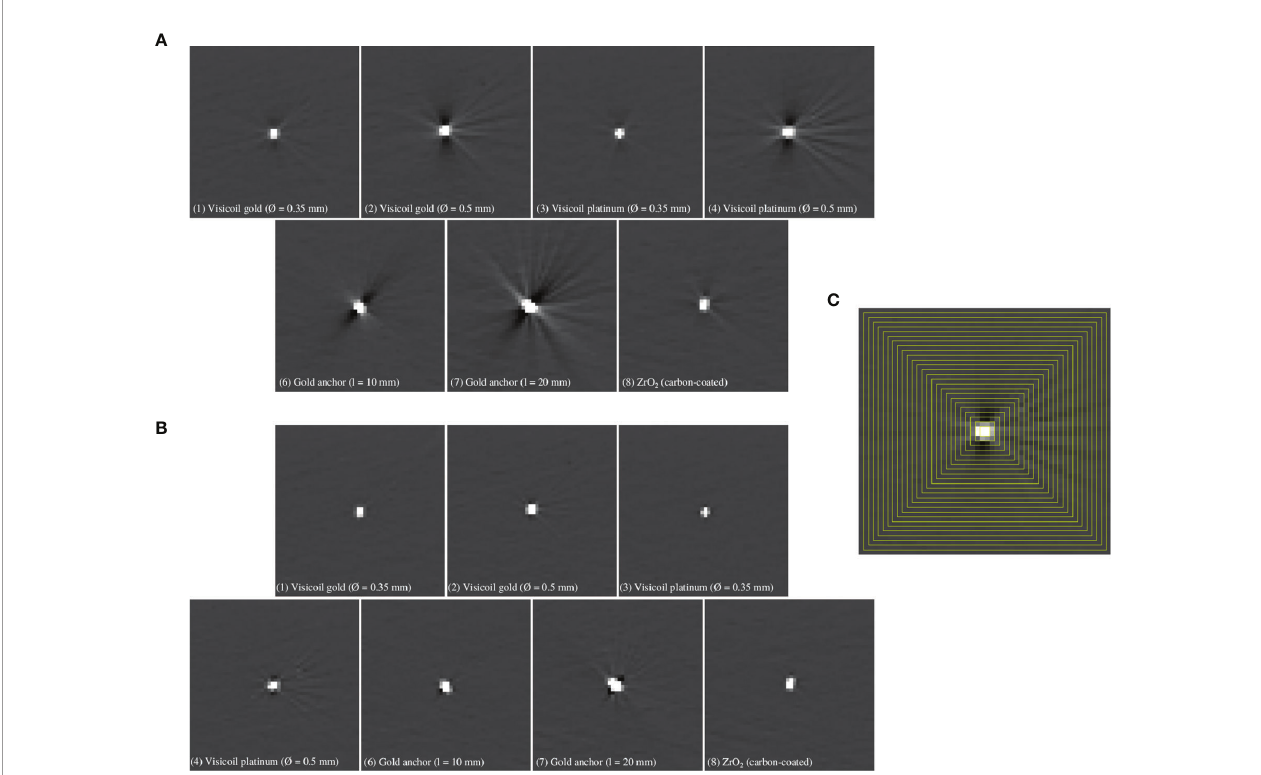
FIGURE 3 | Reconstructed images for conventional treatment planning CT (A) and with iMAR correction (B) of 0.5mm slice thickness for 7 different fi ducial markers ( Table 1 ). (C) Square-shaped rings (yellow lines) used to determine the minimum and maximum values as a function of the distance from the marker, as explained in Section 2.2.1